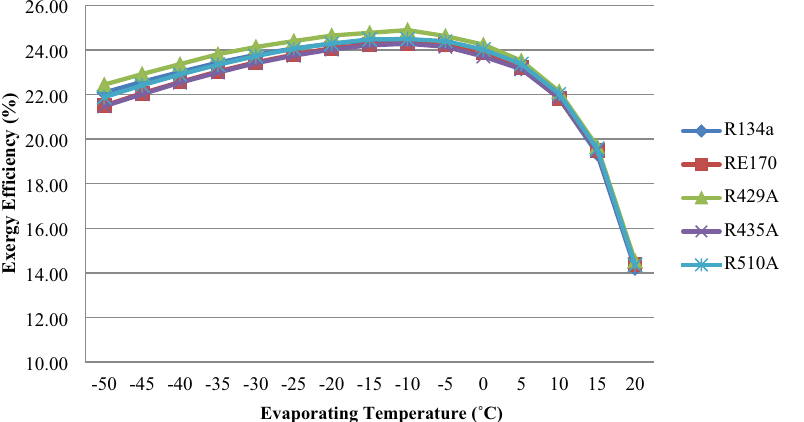
Figure 3. Exergy Efficiency as a Function of Evaporating